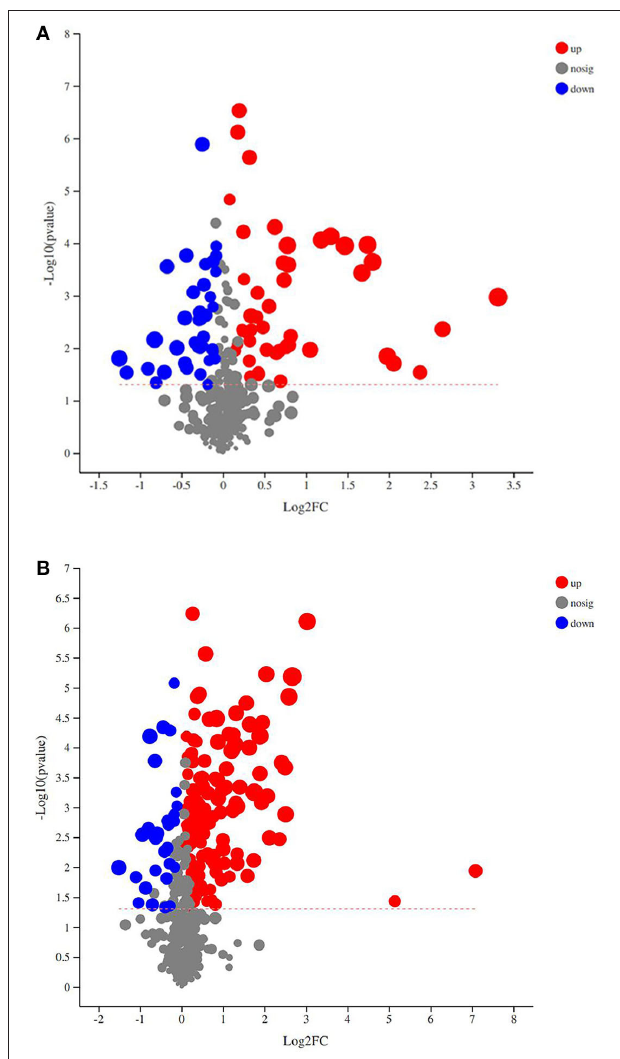
FIGURE 2 | (A,B) were respectively, derived from POS and NEG of the serum samples. In the volcano plot, each point represents a metabolite, and the point size represents the VIP value of this metabolite in the OPLS-DA model. Compared with the CON group, red indicates a significantly upregulated metabolite in the SUP group, whereas blue indicates the opposite, and gray shows no significant difference between the two